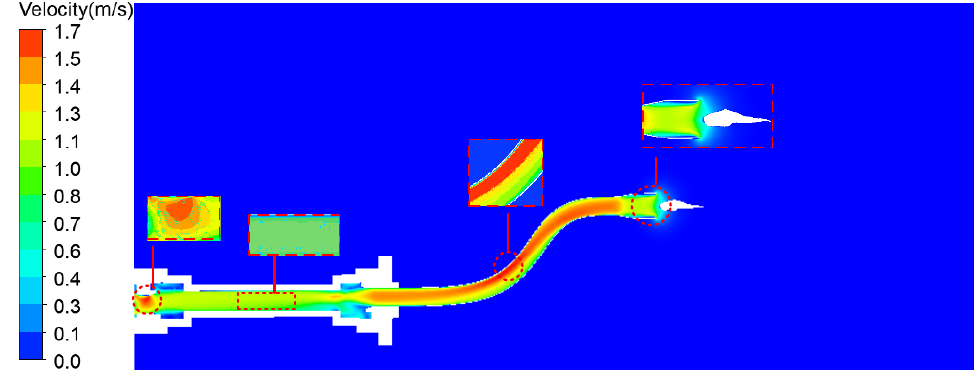
Figure 6. Flow field velocity distribution of HSMPS.